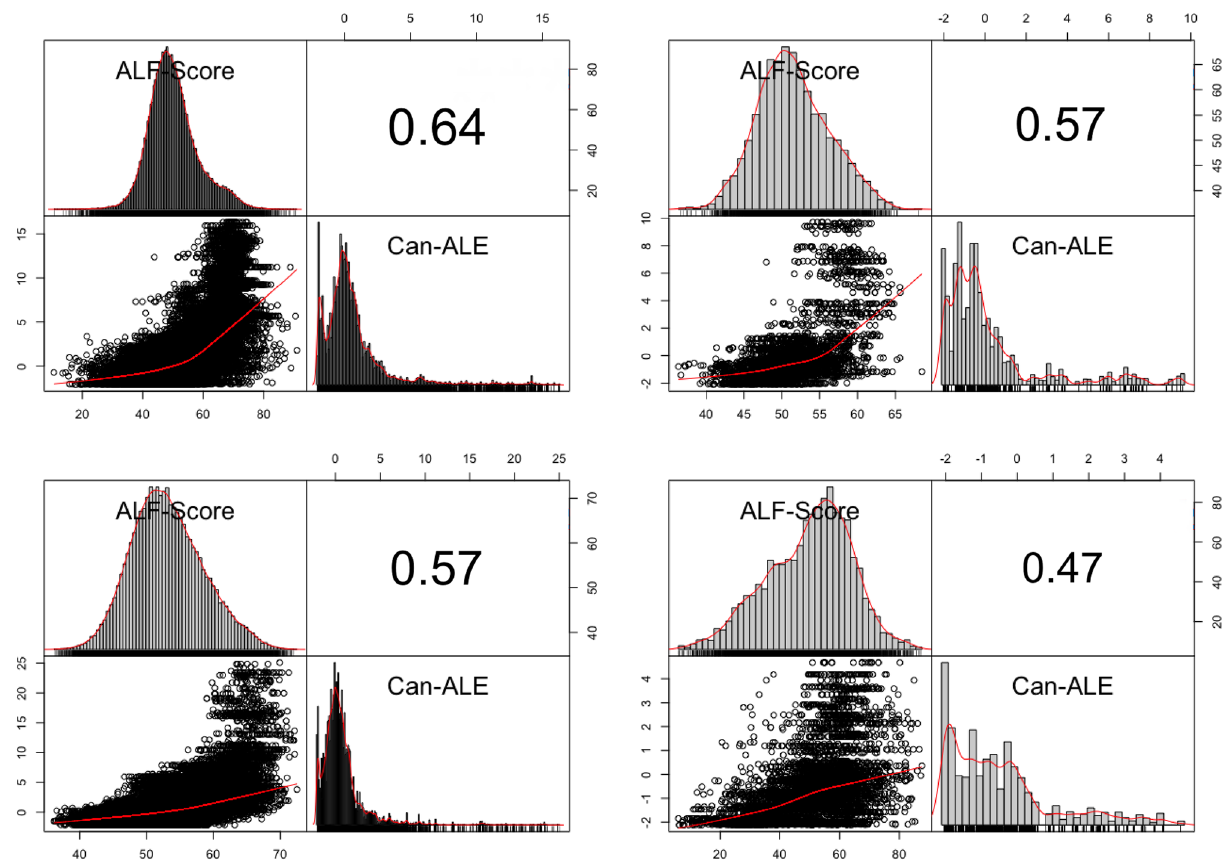
Figure 9. Correlation between ALF-Score++ and Can-ALE for four different cities. Top left: Montréal QC, Top right: Kingston ON, Bottom left: Vancouver BC, Bottom right: St. John’s NL. (Correlation figures generated through RStudio 44 Version 1.2 using PerformanceAnalytics package from